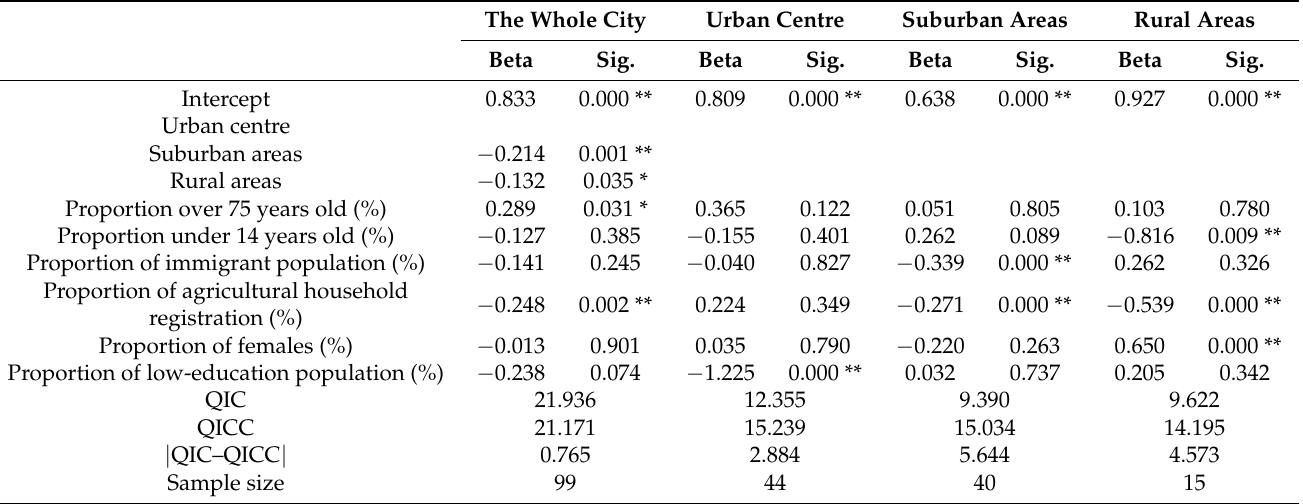
Table 5. GEEs for predicting the area of the flooded proportion over 20 years with respect to the vulnerable groups. P = 20.